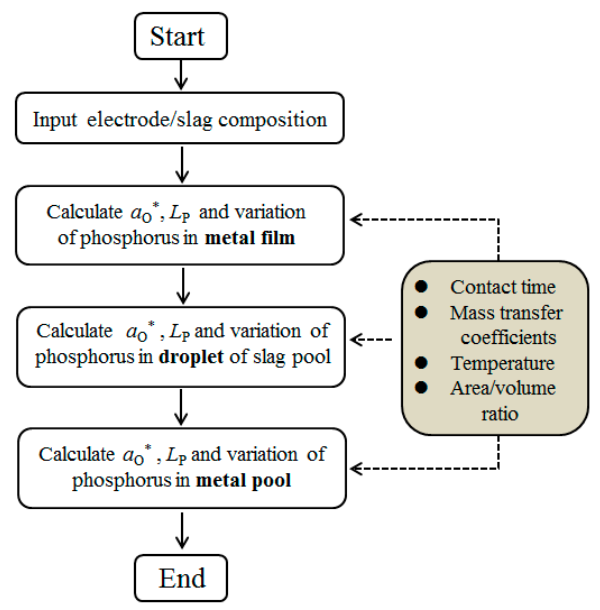
Figure 5. Flowchart of the kinetic model.